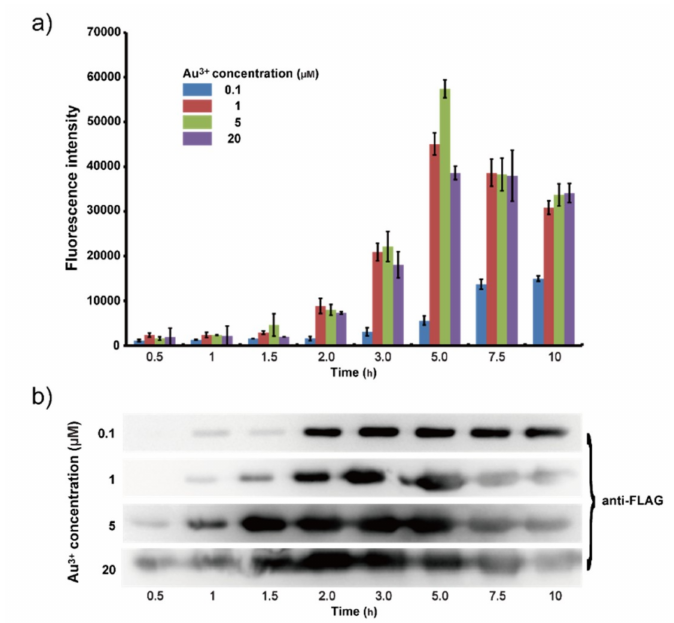
Figure 2. ( a ) Fluorescence measurement of the sensitivity in LB medium containing gradient and time concentrations of Au ions; ( b ) Lpp-OmpA-GolB protein expressed verification.